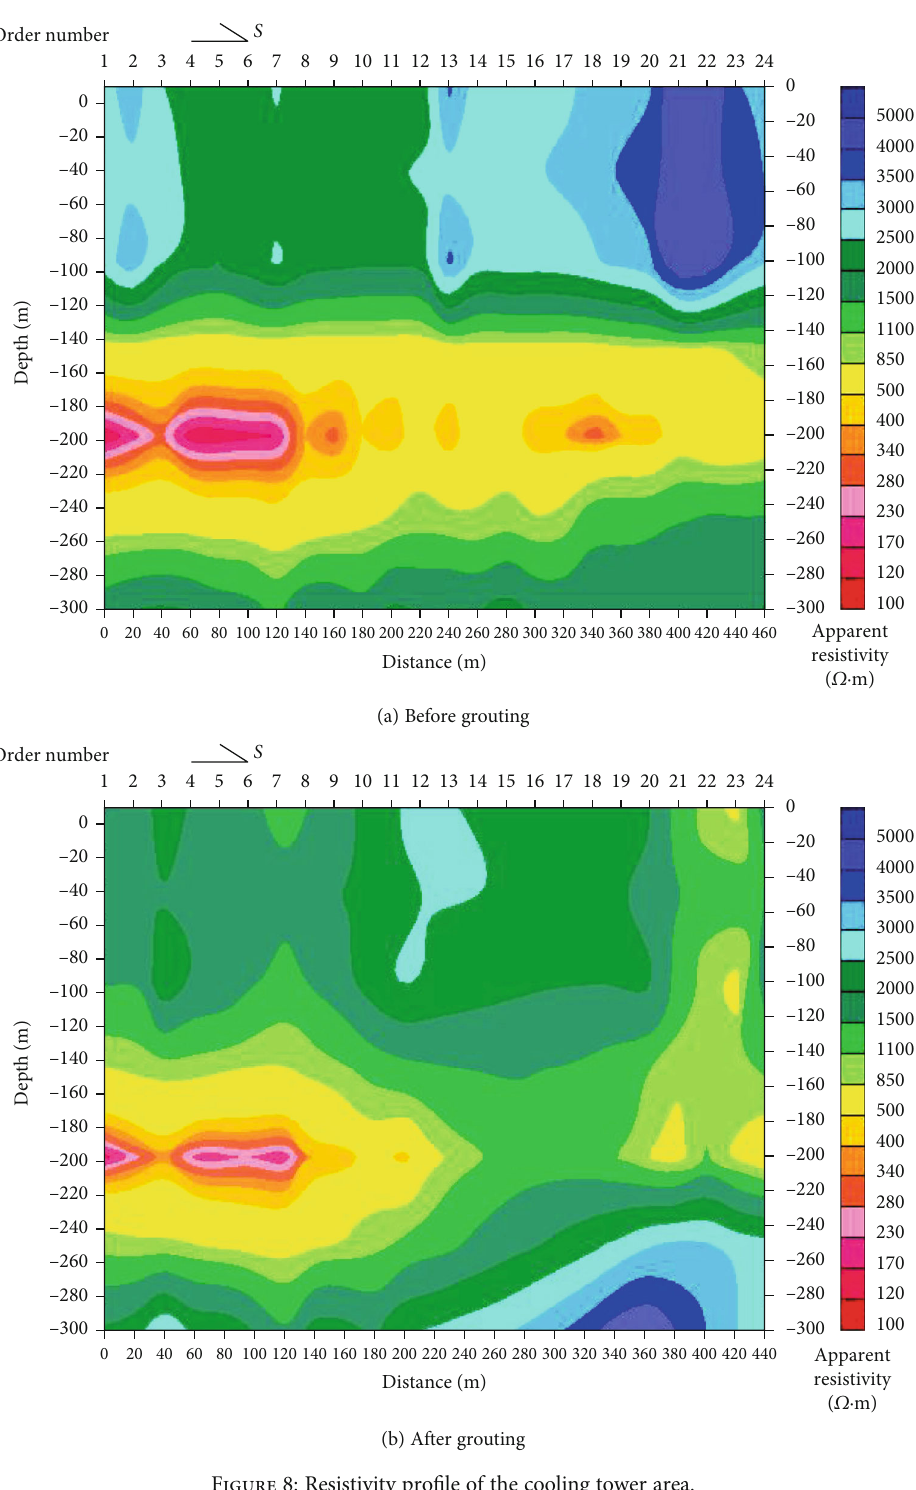
Figure 8: Resistivity pro fi le of the cooling tower